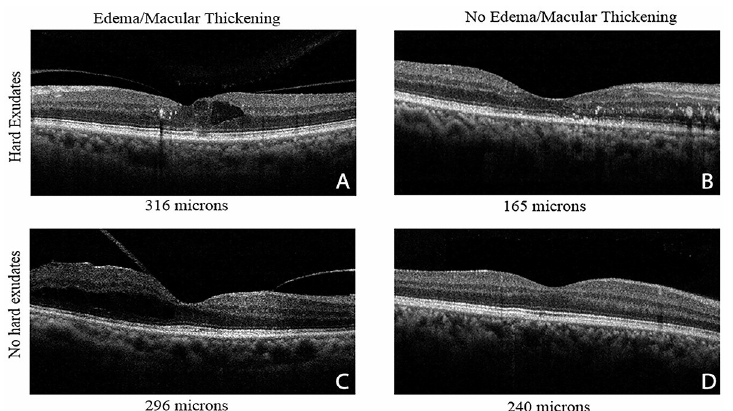
Fig 1. Differences among diabetic eyes that are not fully characterized by retinal thickness, demonstrated with cross-sectional views and average central macular thickness from an iVue SD-OCT. (A) Typical diabetic macular edema, showing a thickened retina that results in a high value of central macular thickness. There are fluid-filled cystic spaces that appear dark, hyper-reflective lipid and protein deposits (hard exudates), and disrupted photoreceptor layers that lie beneath retina blood vessels. The large areas of fluid produce multiply scattered light, instead of leading to interference, and therefore appear dark. (B) Significant pathological changes, but a low value of retinal thickness typically attributed due to damage to neurons and their support cells. There are numerous hard exudates, and significant disruption to retinal layers including photoreceptors. (C) Traction along with a detaching vitreous, the topmost reflective layer that is tilted, leading to retinal thickening, but not very severe diabetic changes. The large black areas within the retina demonstrate the fluid built up by the traction and are consistent with a high value of central macular thickness. (D) Diabetic retina with normal retinal thickness and minimal diabetic changes. These data are from the large dataset collected in a group of clinics for the underserved in Alameda County, CA, as described in ref